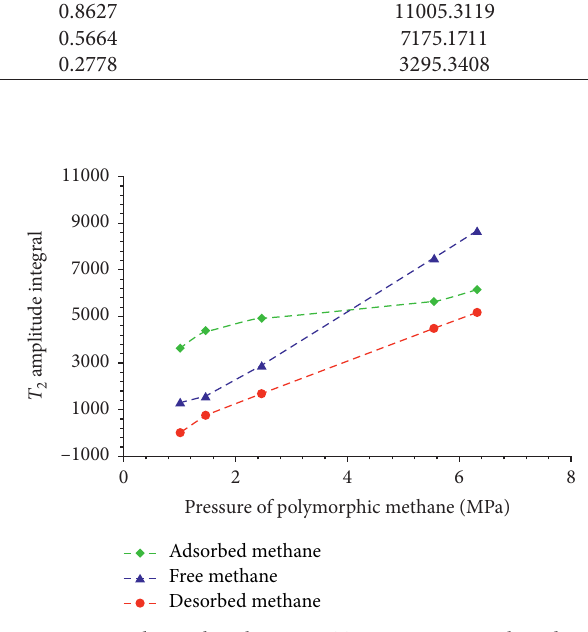
2 spectra integral and gas